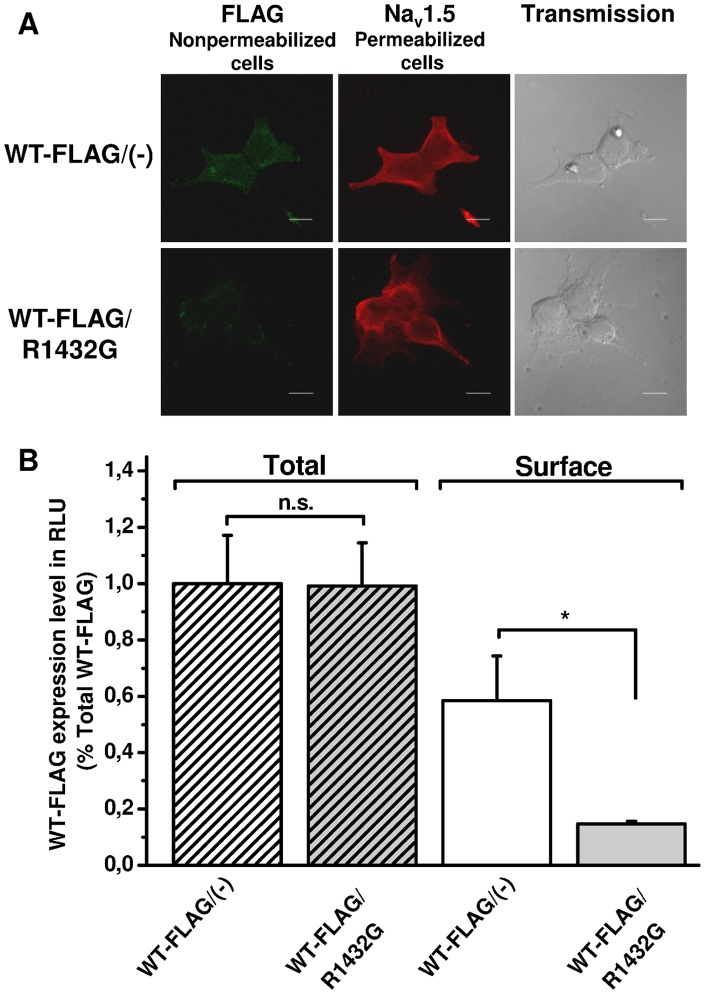
R1432G mutant alters WT channel localization to the cell membrane in the presence of β1-subunit.
A. Confocal imaging of Na channels in cells co-expressing R1432G mutant and Nav1.5/WT-FLAG or expressing Nav1.5/WT-FLAG alone. Immunocytochemistry with anti-FLAG antibodies was performed first on fixed non-permeabilized cells to detect surface FLAG-tagged WT channels (green, left panels). The same cells were then permeabilized to label total mutant and WT Nav1.5 proteins with anti-Nav1.5 antibodies (red, middle panels). Light transmission imaging of the HEK293T cells are presented on the right panels. Scale bar, 10 µm. B. Quantification by luminometry of FLAG-tagged Nav1.5/WT channels in the presence (gray bars) or the absence (white bars) of R1432G subunits in HEK293T cells. Surface and total amount of WT-FLAG channels was measured from non-permeabilized (solid bars) and permeabilized (hatched bars) cells respectively. Data are presented as relative light unit (RLU) normalized to the total WT-FLAG/(-) condition. Data are expressed as mean ± SEM of six independent experiments. *, P<0.05, indicates significant difference with surface WT-FLAG/( ) condition (t-test). All experiments were realized in the presence of the β1-subunit.